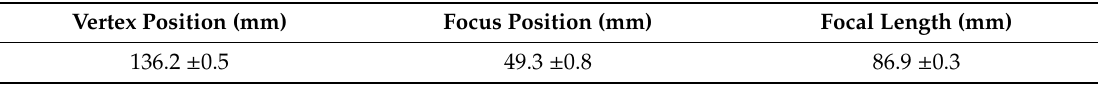
Figure 12. Focal length, focus, and vertex positions calculated for each parabolic section of the reconstructed profile. The dotted square indicates the presence of a “step” in the longitudinal section. Table 1. Result of SLP (structured light profilometry) on m-PTC (micro-parabolic trough